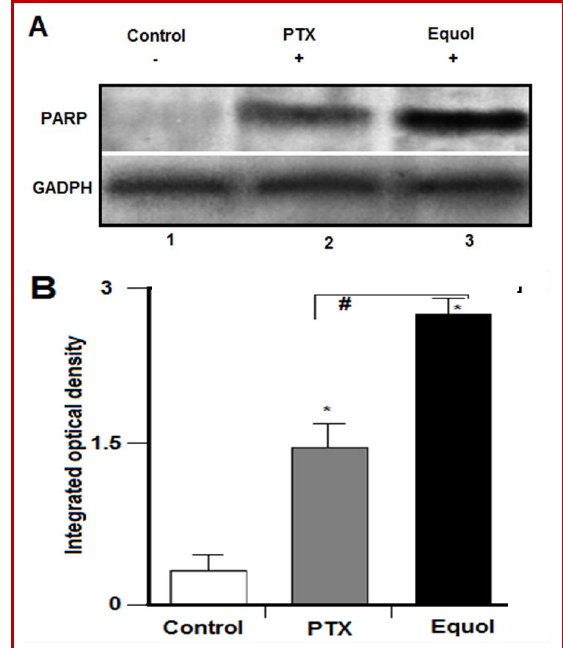
Figure 7 : Representative immunoblot and quantitative analysis of PARP protein expression. (A) Western blot analysis show- ing cleavage of PARP in SKOV-3 cells upon treatment with an IC 50 dose of equol and PTX. The PARP was detected using specific antibodies. Rabbit Anti-PARP-1 (cleaved p25) mono- clonal antibody was attached to the secondary goat anti-rabbit antibody, conjugated with alkaline phosphatase at a dilution of 1/2000. Rabbit anti-GAPDH antibodies were used as internal controls. The blot was developed with BCIP/NBT. (B) The densitometric volume of the PARP bands is expressed relative to the densitometric volume of the loading control gene